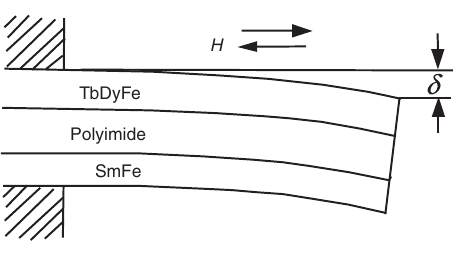
Figure 2 Deflection of a GMF fin.